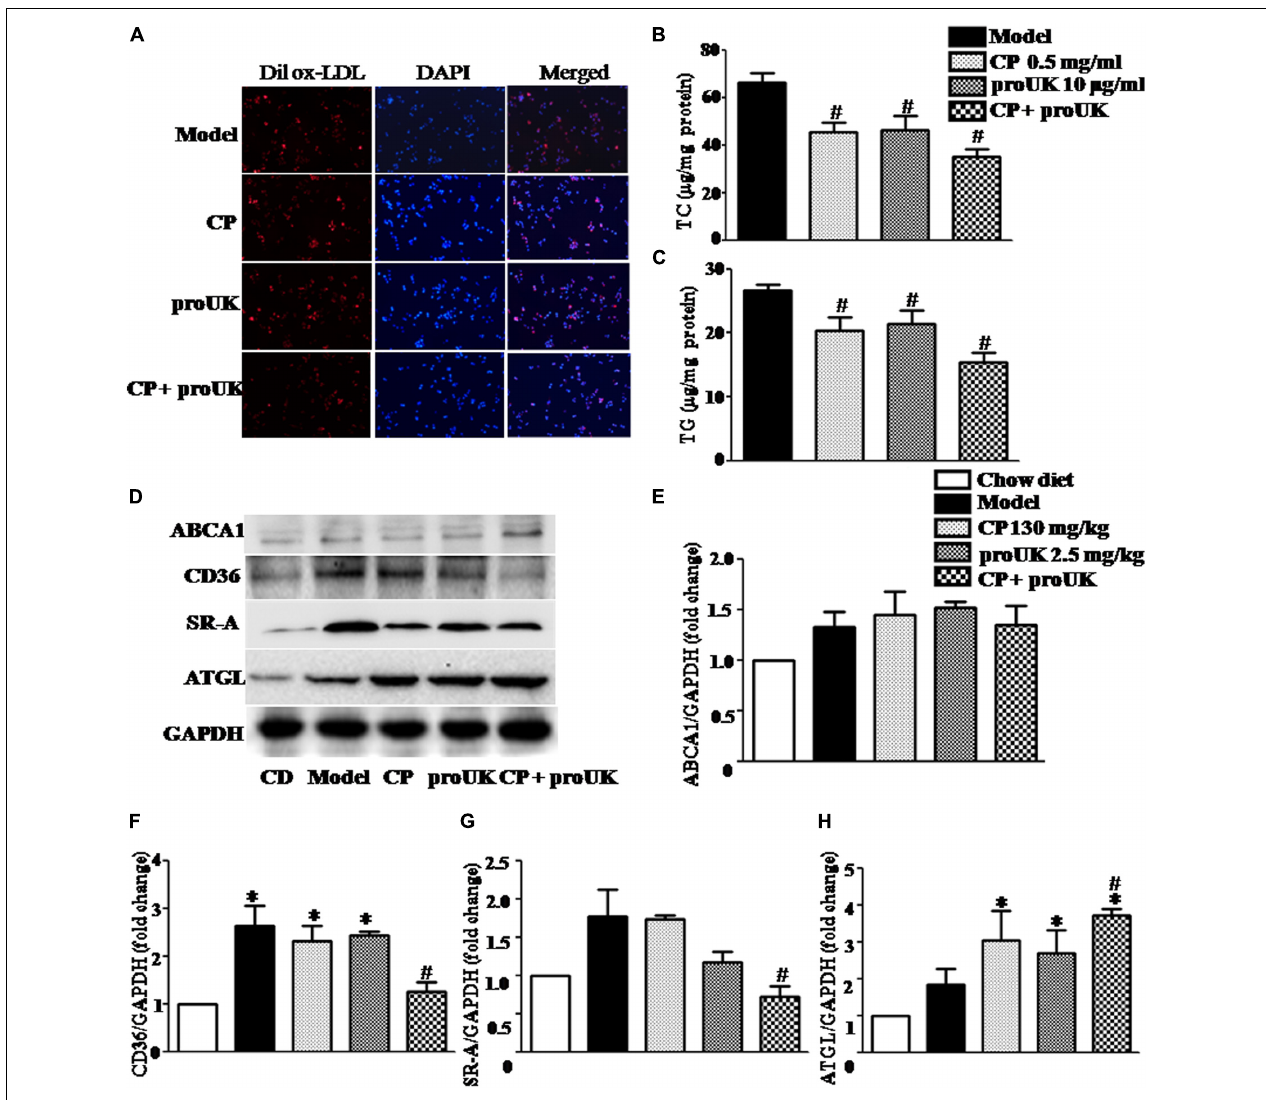
FIGURE 7 | CP plus proUK decreases the accumulation of lipids in RAW264.7 macrophages and the levels of CD36 and SRA in the aorta of LDLR − / − mice. (A) The accumulation of lipid droplets in RAW264.7 macrophages. (B) The effect of CP or/with proUK on the level of TC in RAW264.7 macrophages. (C) The effect of CP or/with proUK on the level of TG in RAW264.7 macrophages. (D) Western blot of ABCA1, CD36, SRA1 and ATGL from the aorta in LDLR − / − mice from different groups. (E) The quantitative analysis of ABCA1 expression in aorta from different groups. (F) The quantitative analysis of CD36 expression in aorta